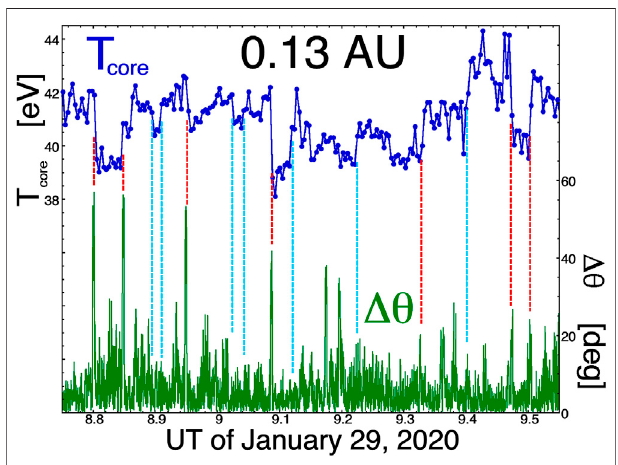
FIGURE 6 | For 48 min of time-series measurements by Parker Solar Probe on January 29, 2020 the relationship between jumps in the core- electron temperature(blue curve) and current-sheet crossings asindicated by strongtemporalchangesinthemagnetic- fi elddirection(greencurve)are